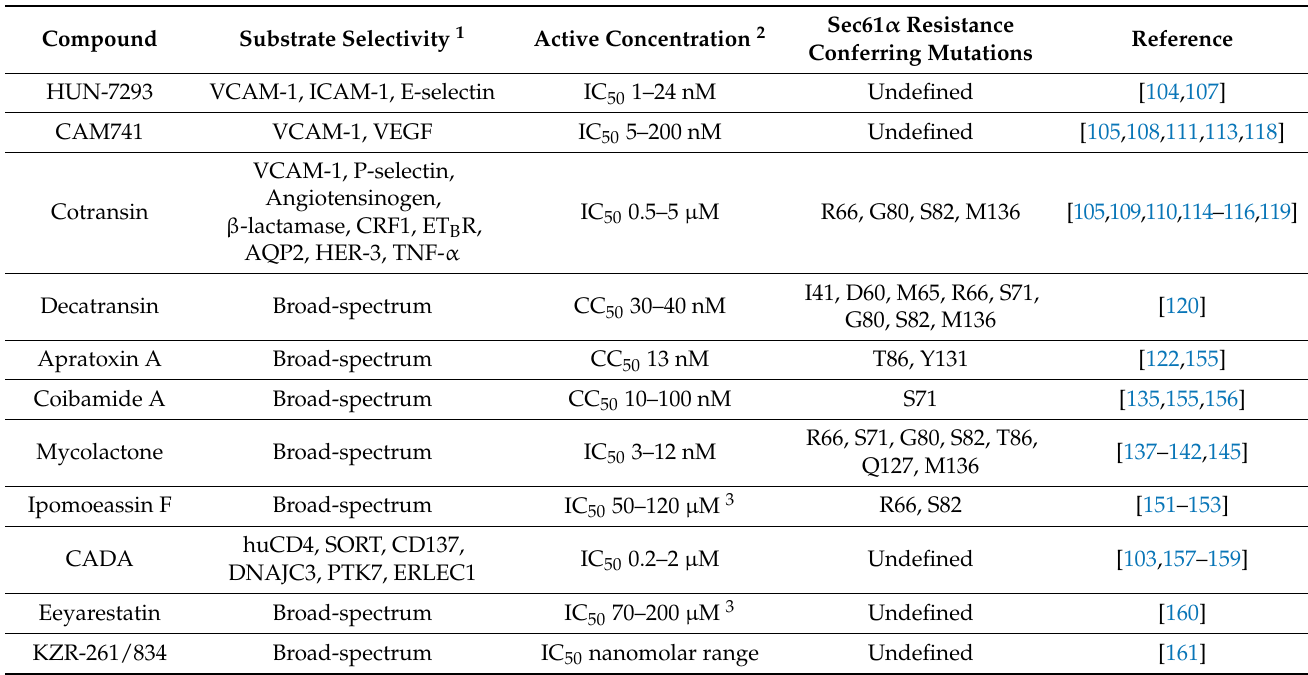
1 VCAM-1: Vascular cell adhesion molecule 1, ICAM-1 Intercellular adhesion molecule 1, VEGF: Vascular endothelial growth factor, CRF1: Corticotropin releasing factor 1, ET B R: Endothelin B receptor, AQP2: Aquaporin 2, HER-3: Human epidermal growth factor receptor 3, TNF- α : Tumor necrosis factor α , huCD4: human cluster of differentiation 4, SORT: Sortilin, PTK7: Protein tyrosin kinase 7, ERLEC1: Endoplasmic reticulum lectin 1. 2 IC 50 : inhibitory concentration producing 50% reduction in biological activity. CC 50 : cytotoxic concentration causing 50% cell death. 3 IC 50 in cell-free in vitro translocation